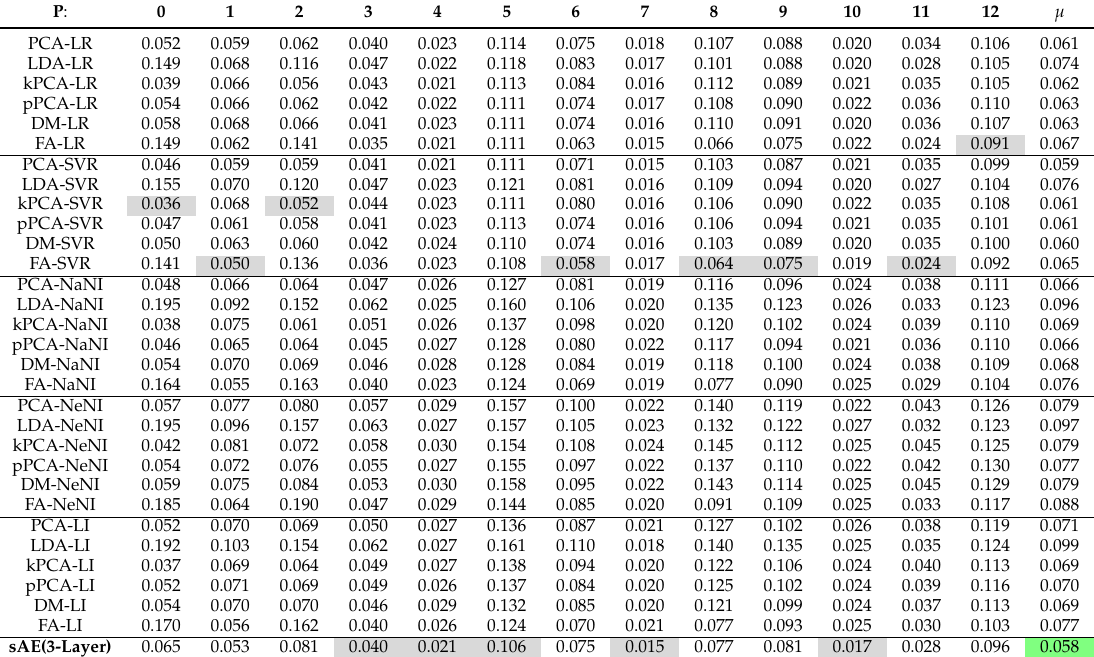
Table 5. Mean reconstruction error per parameter using combinations of dimensionality reduction and reconstruction techniques for the weighted parameterers, with the lowest reconstruction error highlighted in grey. The final column shows the mean ( µ ) error across all techniques, while the model with the lowest mean reconstruction error (Stacked Autoencoder) is highlighted in